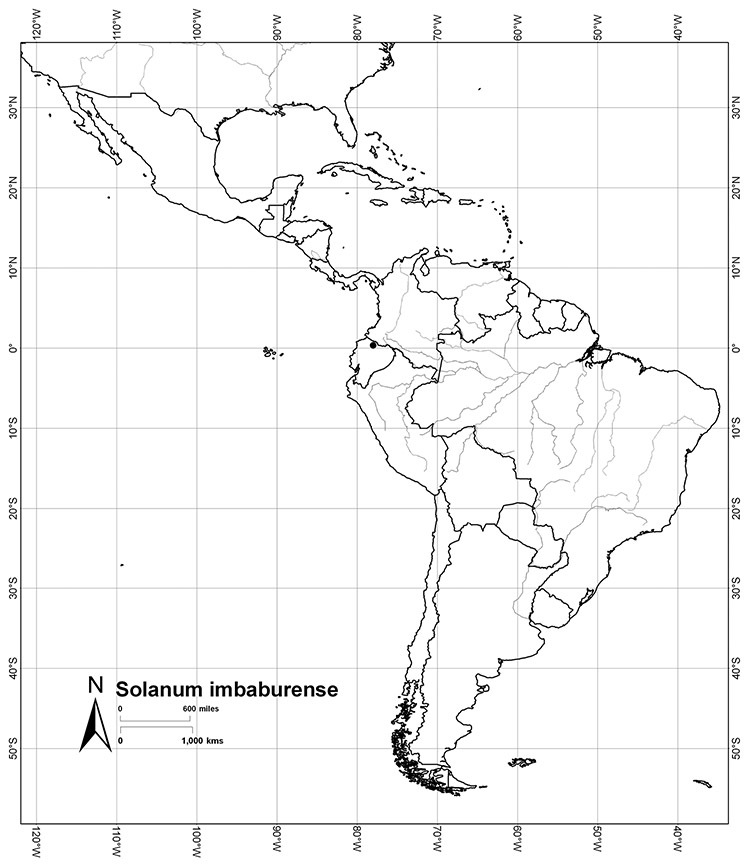
Distribution of Solanum imbaburense S.Knapp